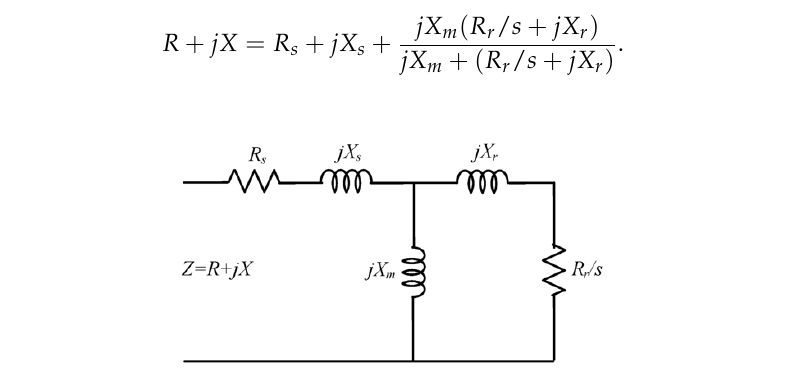
Figure 1. Steady-state equivalent circuit.